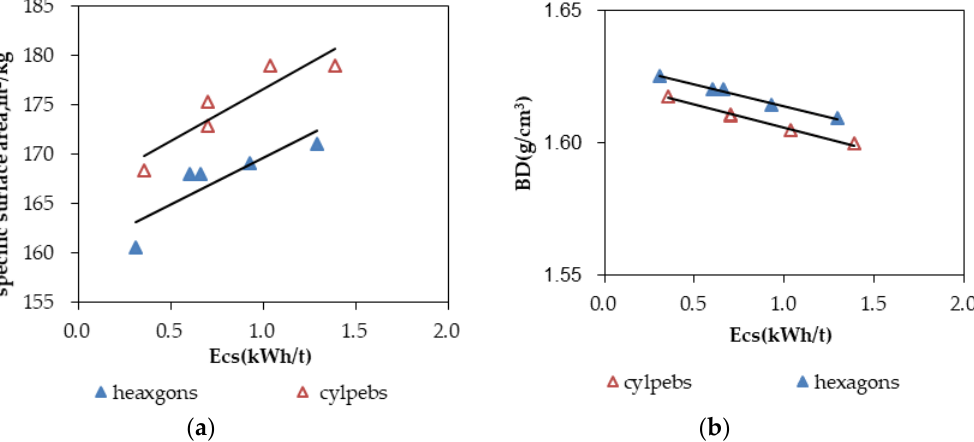
Figure 14. ( a ) Relationship between specific surface area and specific energy; ( b ) Relationship between bulk density and specific energy.